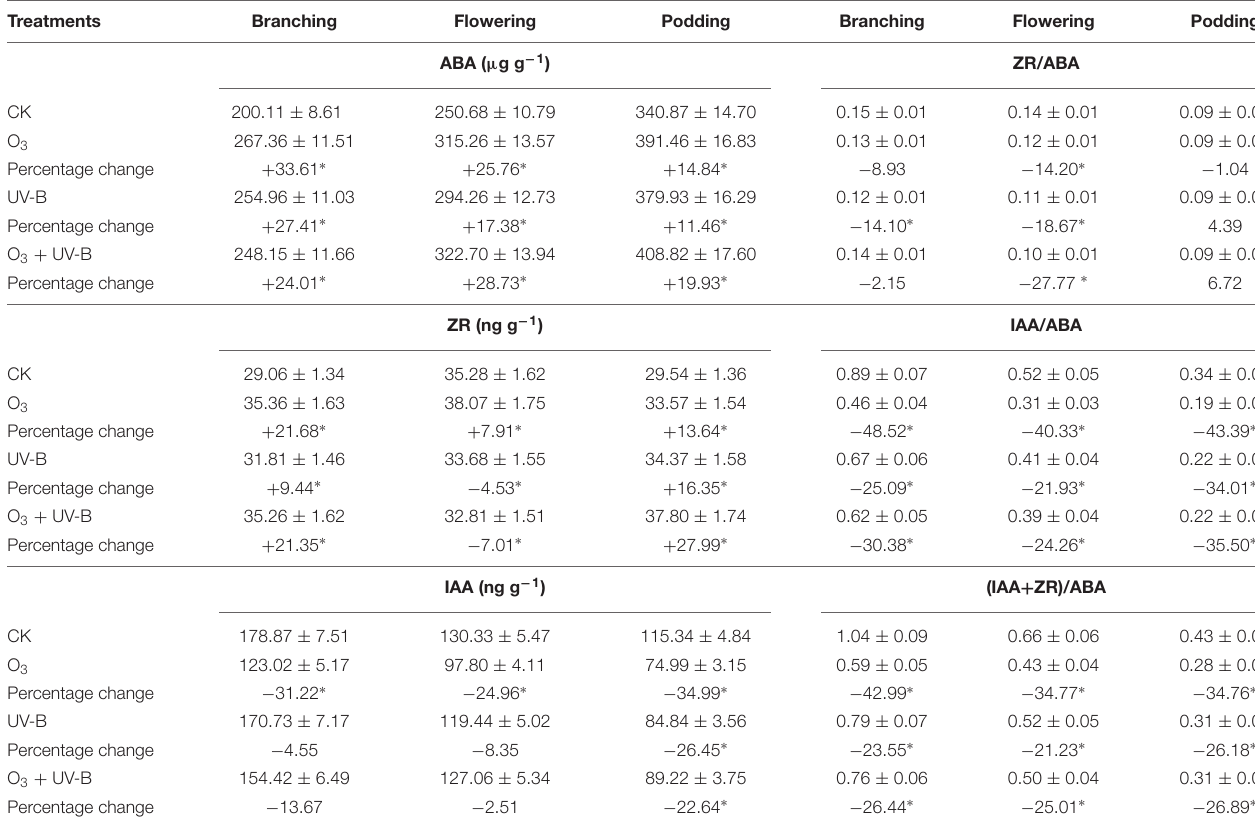
TABLE 2 | Differences in endogenous hormones of soybean roots in response to control treatment (CK), elevated O 3 treatment (O 3 ), enhanced UV-B treatment (UV-B) and O 3 + UV-B treatment (O 3 + UV-B) at stages of branching, flowering, and podding (mean ± SD, n = 3). Treatments Branching Flowering Podding Branching Flowering Podding